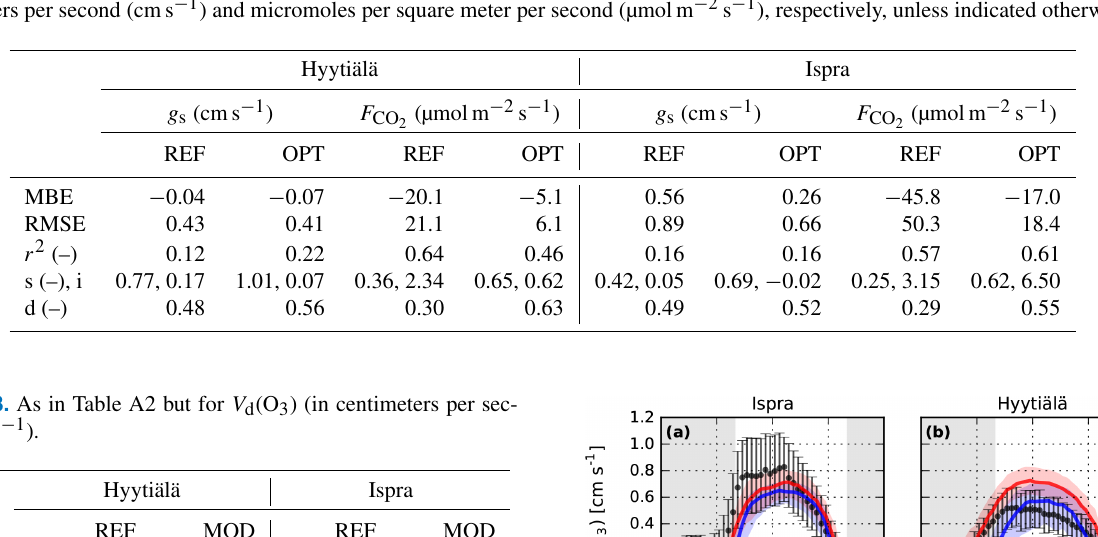
Table A2. Model performance statistics of MLC-CHEM before and after A - g s optimization for canopy stomatal conductance and CO 2 flux. Shown are several conventionally applied performance metrics (MBE, RMSE, slope (s), and intercept (i) of a linear regression fit of simulations against observations and r 2 from ordinary least squares regression), as well as the index of agreement (d). The units are